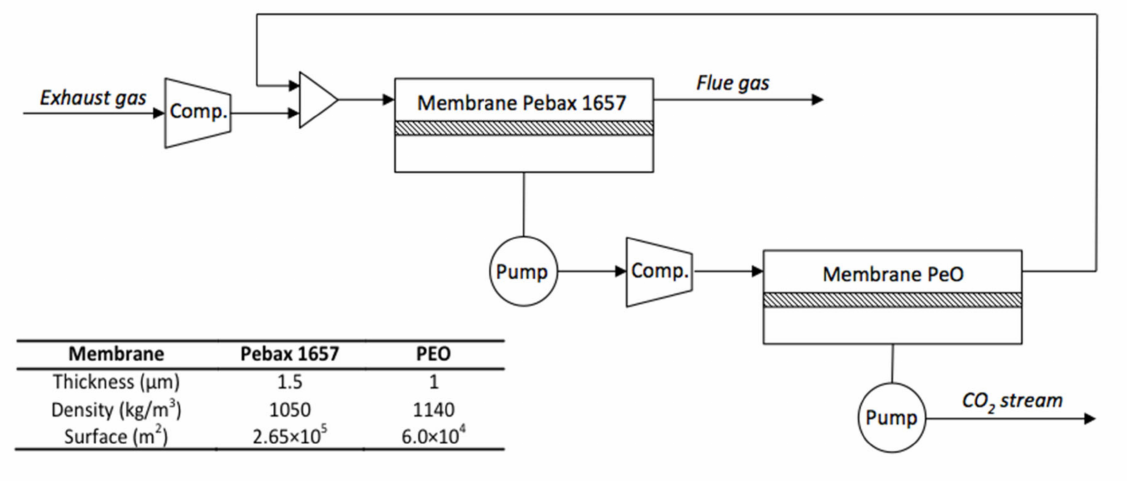
Figure 2. Schematic representation of the selected membrane process. Table 2. Main characteristics of the chemical absorption with MEA.